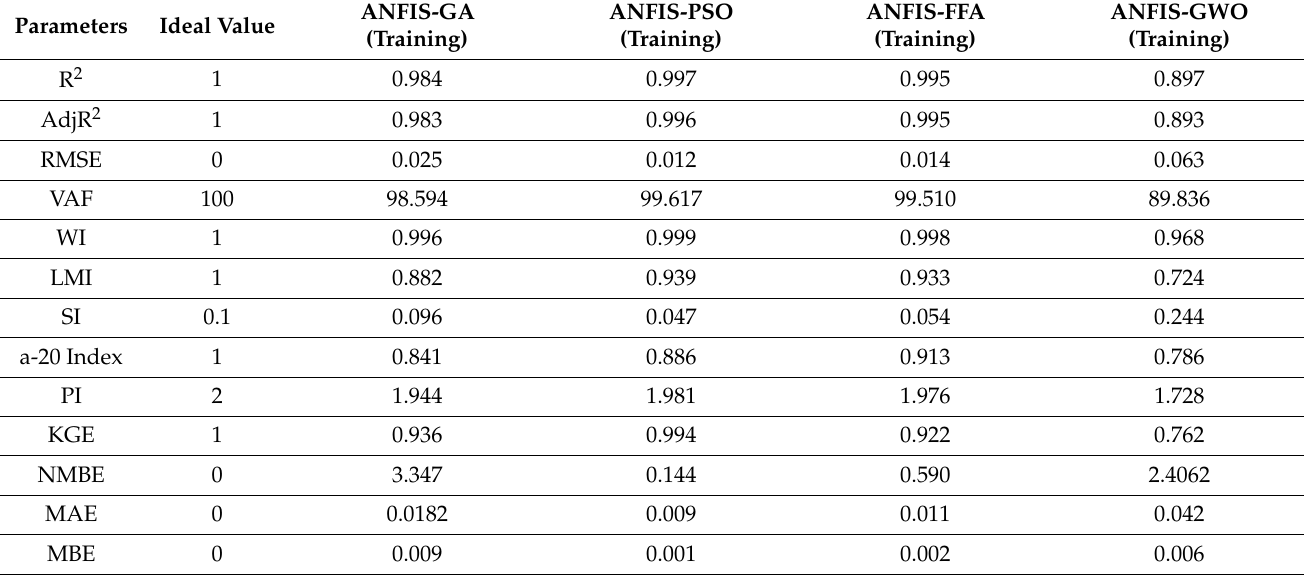
Table 2. Comparison of model prediction power (training dataset).